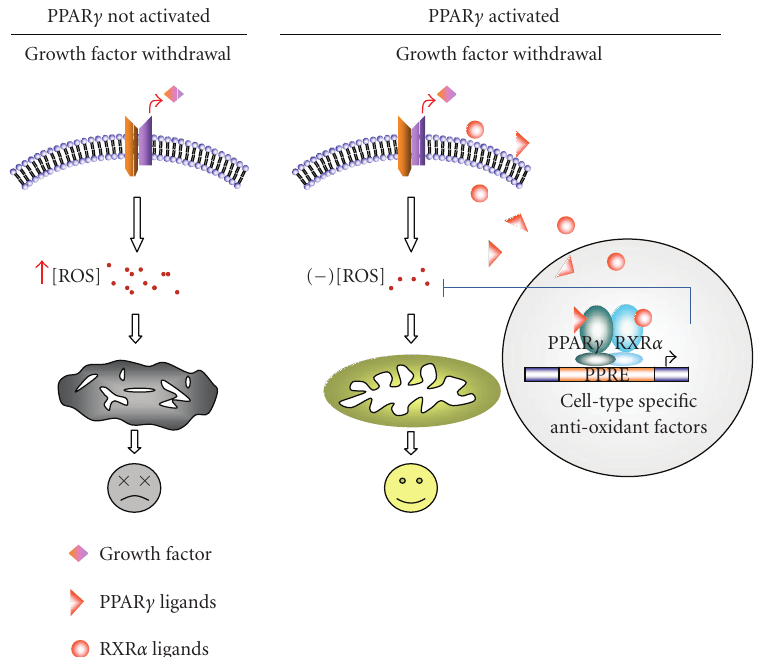
Figure 1: Schematic diagram showing how PPAR γ increases cell survival in growth factor/nutrient-deprived cells . Growth factor/nutrient withdrawal induces ROS production. In the absence of PPAR γ activation, increased levels of ROS inhibit mitochondrial electron transport, leading to mitochondrial depolarization, caspase activation, and cell death. When PPAR γ is activated, the increase in ROS is attenuated by the receptor through transcriptional upregulation of cell type specific antioxidant factors, such as catalase, Cu/Zn-SOD (SOD1), Mn-SOD (SOD2), or UCP2. The transcriptional upregulation of these genes by PPAR γ may or may not be direct (shown to be direct in the diagram for